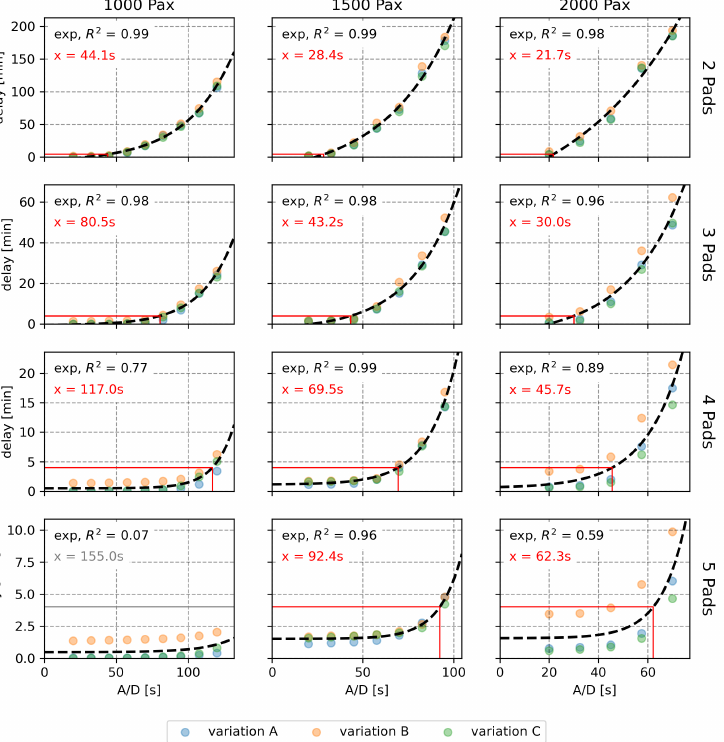
Figure 11. Simulation study under variation of demand, number of pads and approach and departure time (A/D).